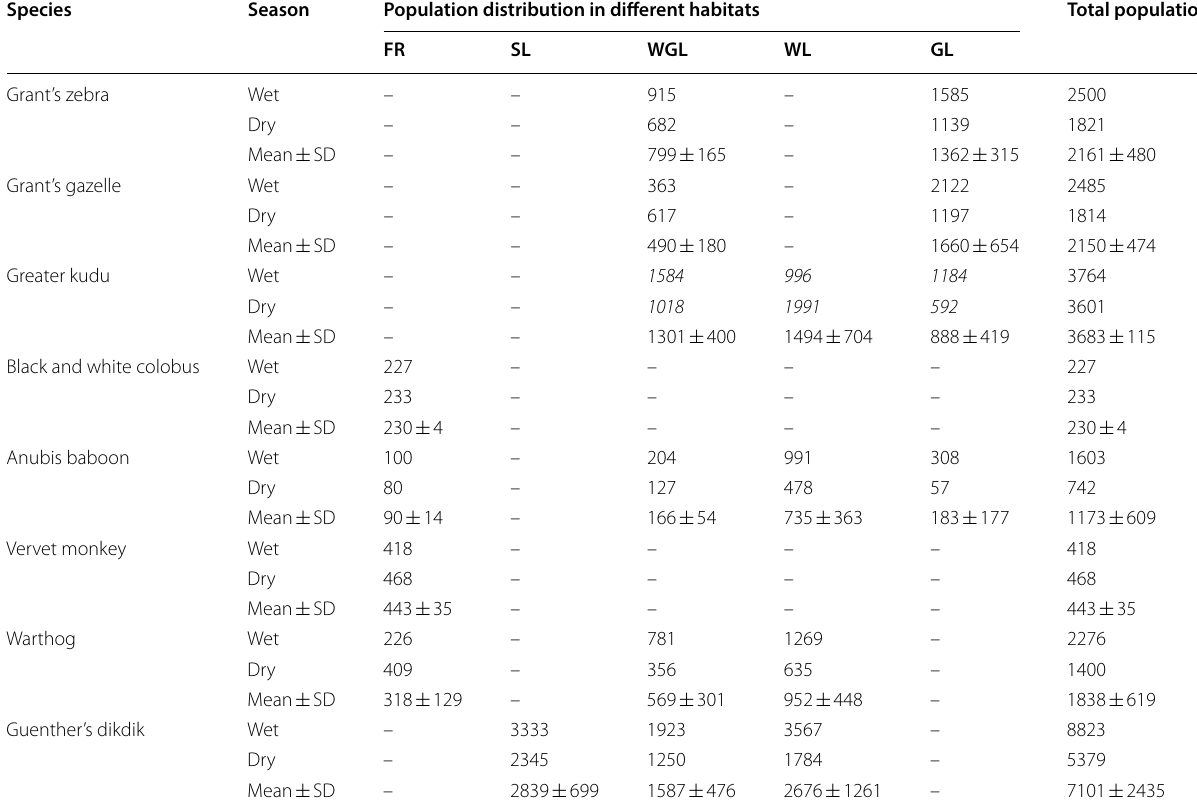
FR forest, SL shrubland, WGL wooded grassland, WL woodland, GL grassland